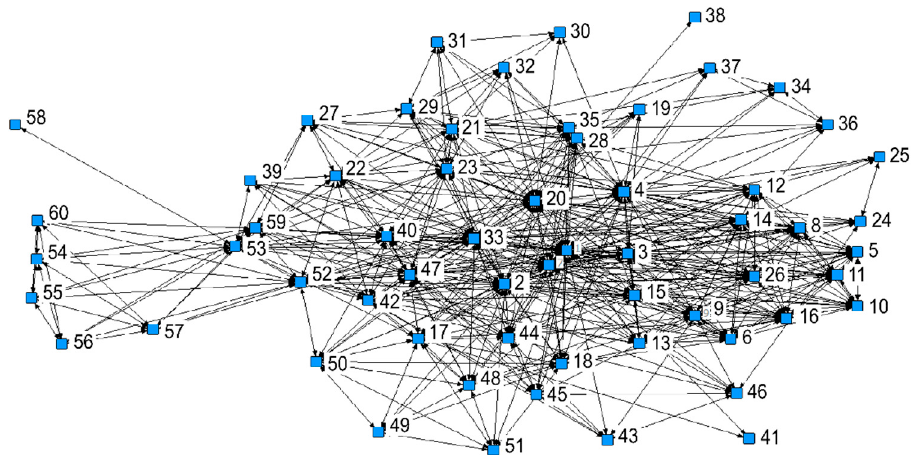
Figure 1. The map of guanxi matrix in Case A.